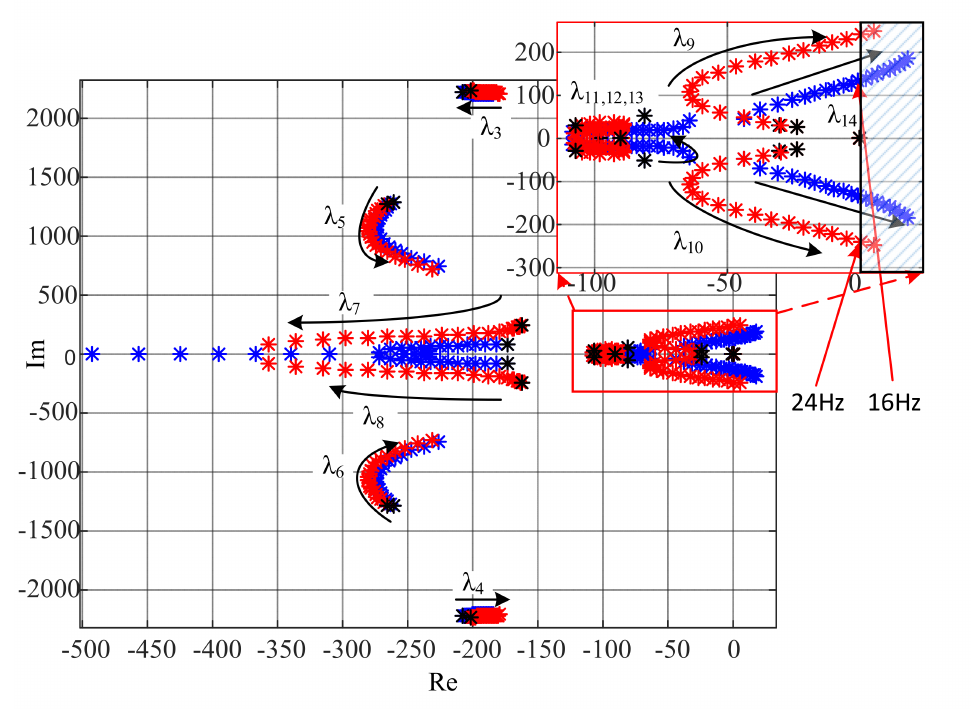
Figure 11. Sensitivity of system eigenvalues under variation of PLL control